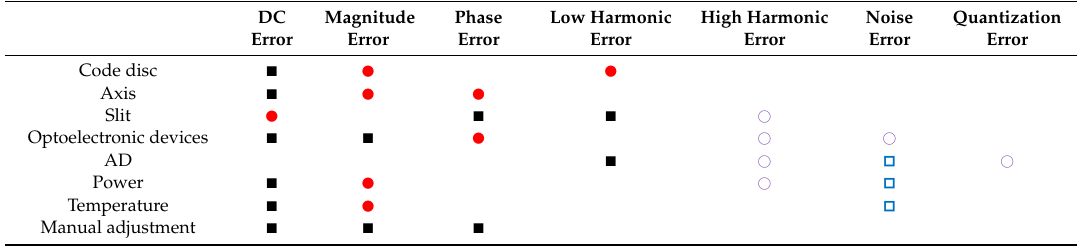
Table 1. The impact of design and debugging on subdivision